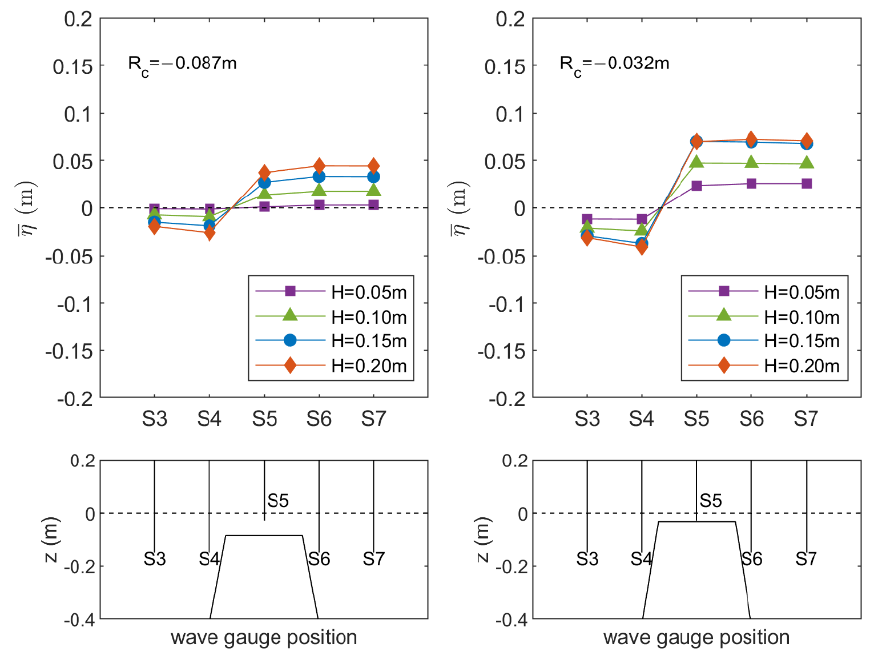
Figure 14. Piling-up behind the submerged breakwater with R c = − 0.087 m ( left panel ) and R c = − 0.032 m ( right panel ) for regular waves with different wave heights H = 0.05 m–0.020 m and a wave period T = 2.0 s.